Question: Does the figure show an increasing or a decreasing trend?
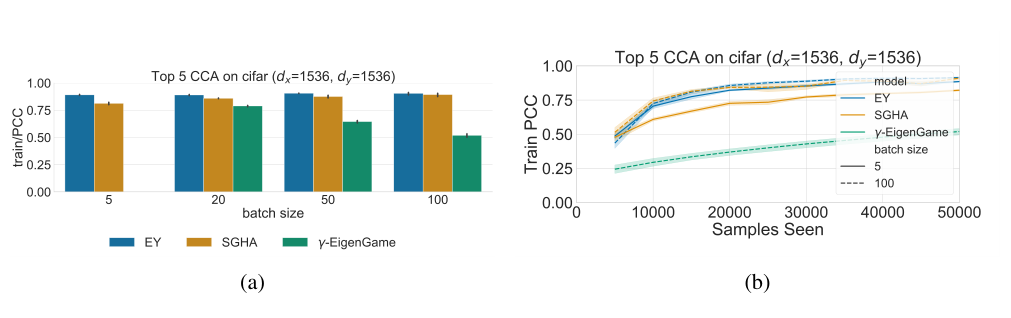
Answer: increasing